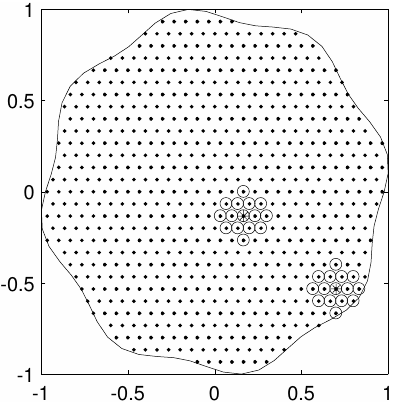
Figure 1. Fifteen-node stencil example for the bumped-disk